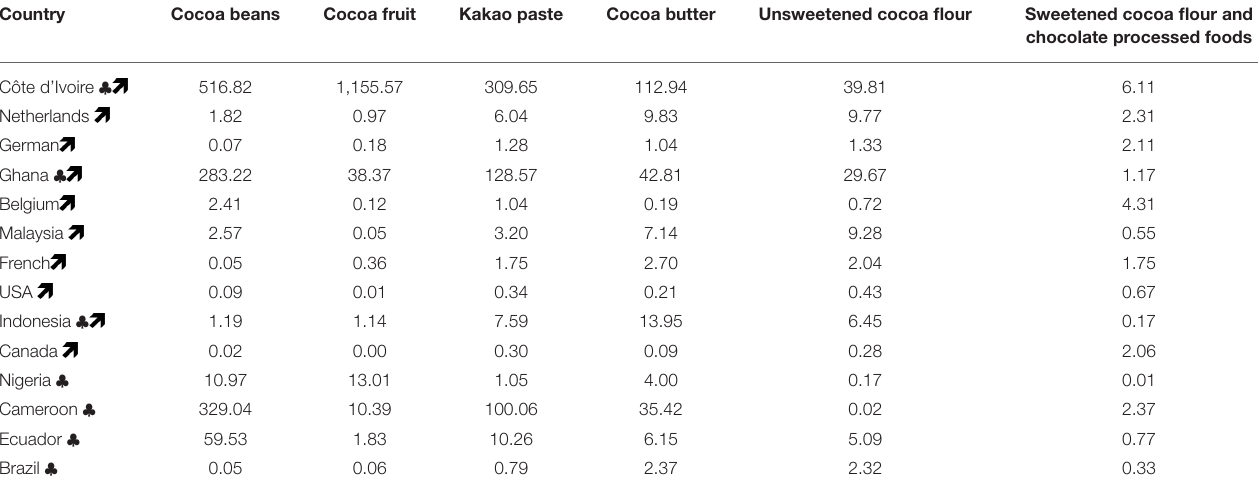
Country Cocoa beans